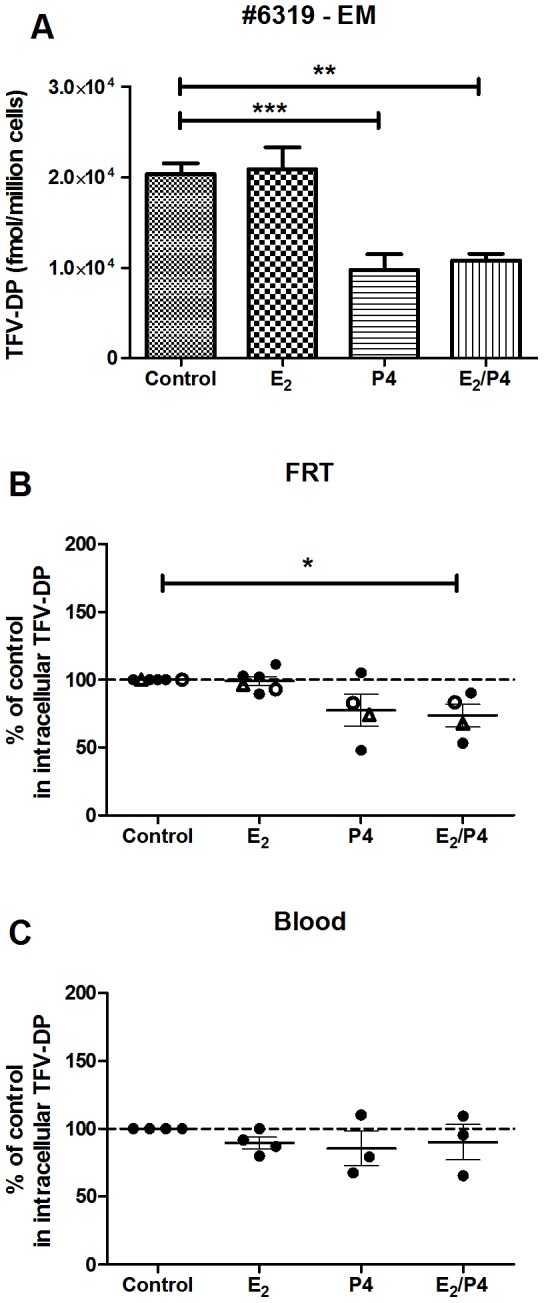
Effect of estradiol and/or progesterone on TFV-DP levels in CD4+ T cells from FRT and blood.TFV-DP levels were measured by LC-MS/MS in purified FRT and blood CD4+ T cells treated with TFV (1 mg/ml) and either estradiol (5×10−8 M), progesterone (1×10−7 M), or the combination for 24 hr. Values are expressed as fmol/million cells in (A) EM CD4+ T cells (patient number 6319). The Bars represent mean and SEM from triplicate cultures. Data were normalized to % of control values from (B) FRT CD4+ T cells (n = 4–6) and (C) blood CD4+ T cells (n = 3–4). Dashed line indicates an assigned value of 100. Each circle or triangle represents a different patient or blood donor. Dark circles indicate (B) EM CD4+ T cells or (C) blood CD4+ T cells. Open circles indicate CX CD4+ T cells and triangles indicate ECX CD4+ T cells. The mean and SEM are shown. *, p<0.05, **, p<0.01, ***, p<0.001.